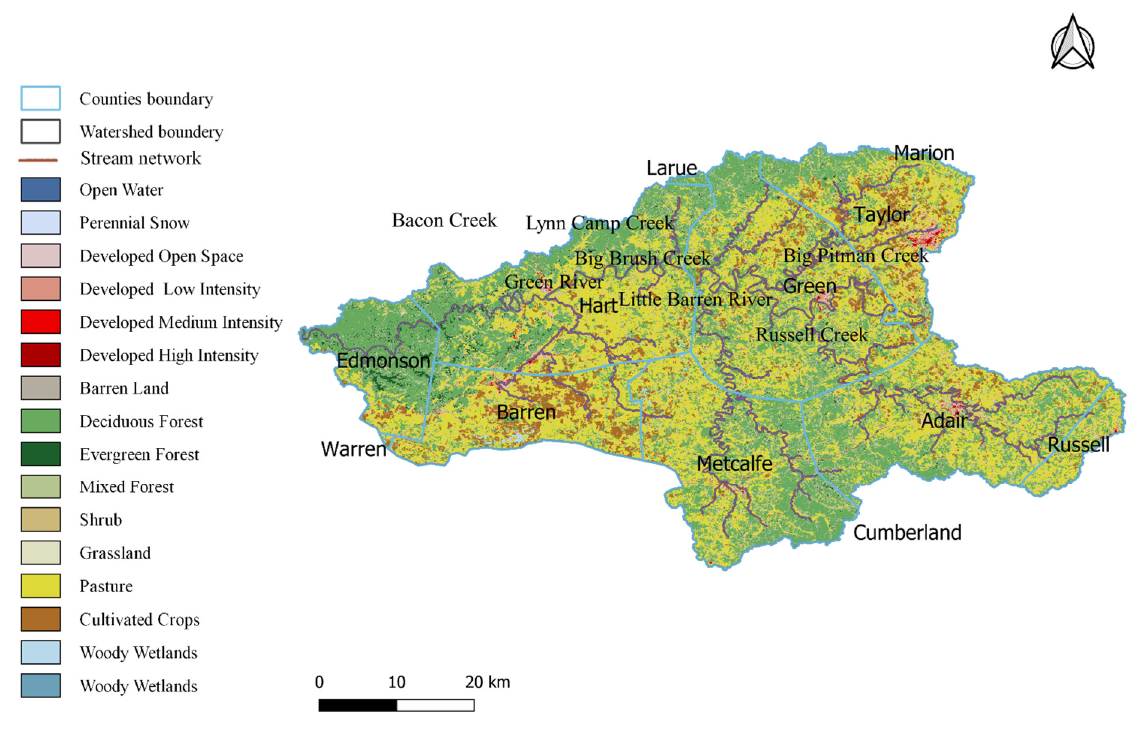
Figure 2. Land Use Map of Upper Green River Watershed.